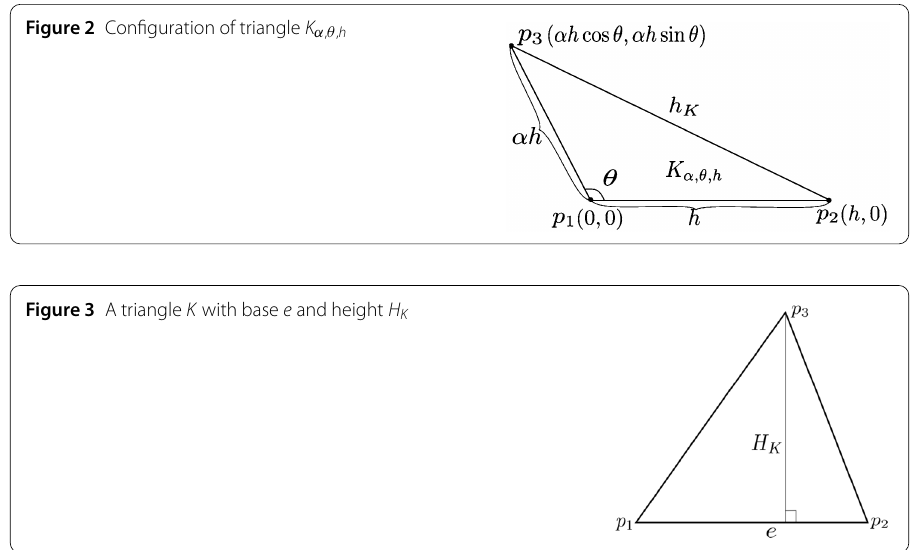
Figure 3 A triangle K with base e and height H